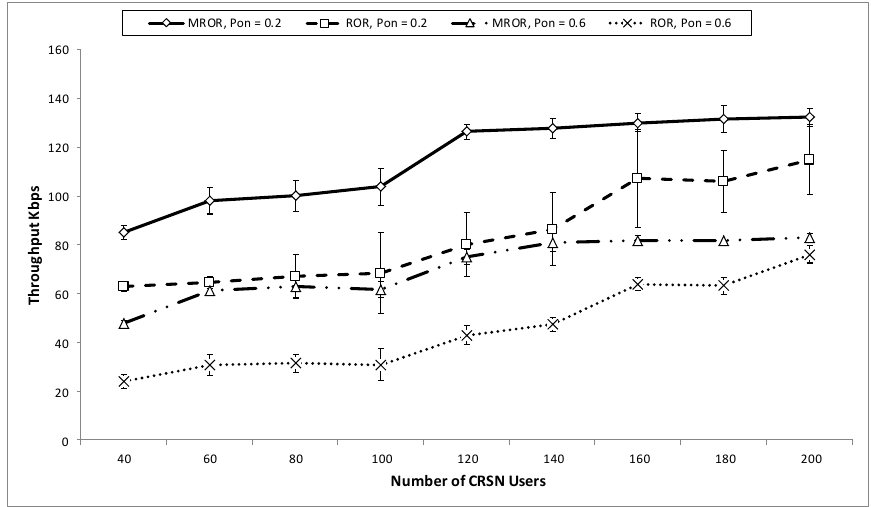
Figure 13. Throughput vs . number of network